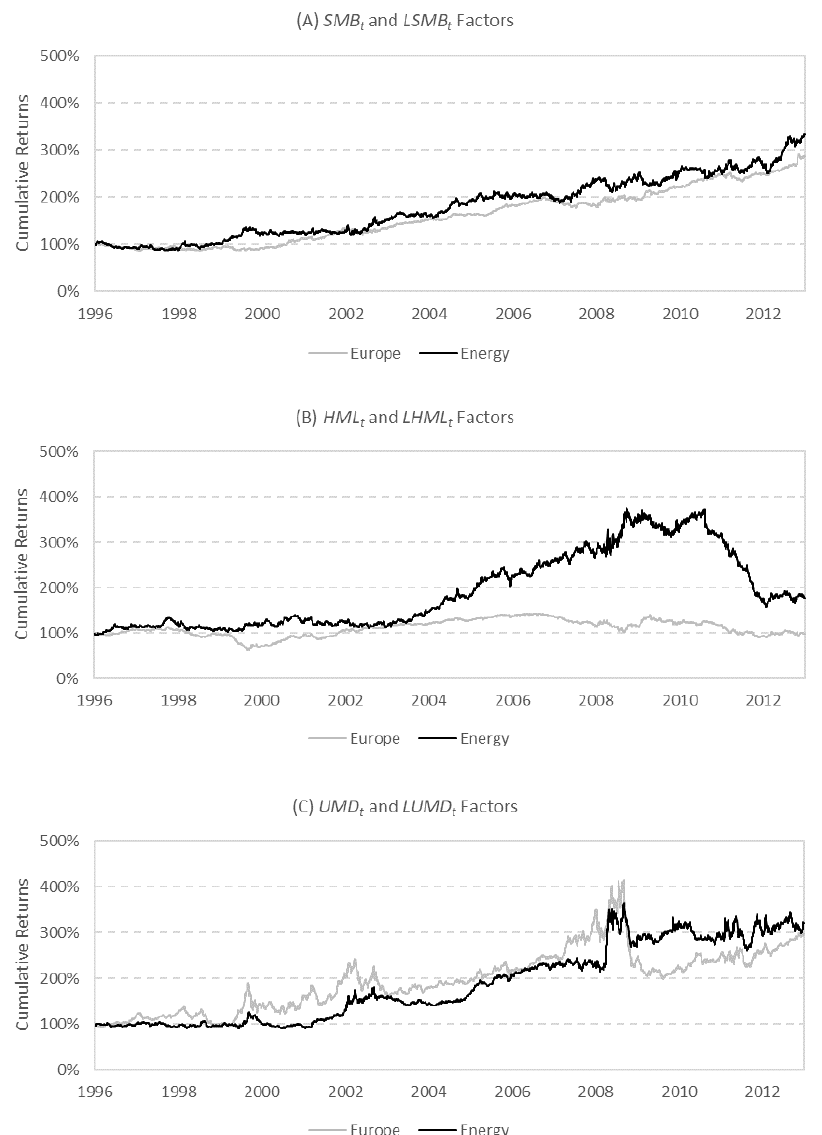
Figure 2. Comparison of cumulative returns for global and local stock market risk factors. This figure presents the cumulative returns of the three stock market risk factors: the size, value and momentum. The black line represents local stock market risk factors specific to energy utilities, including LSMB t , LHML t and LUMD t . The grey line represents global stock market risk factors for European stocks generally, including SMB t , HML t and UMD t